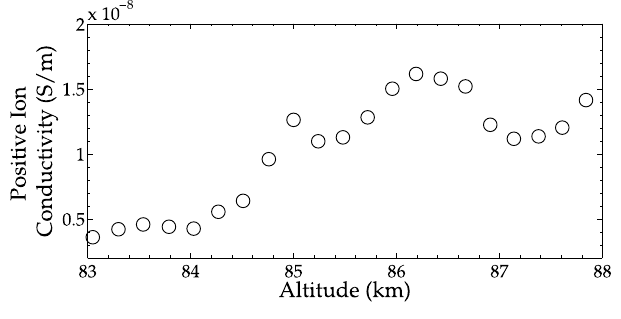
Fig. 6. High time resolution comparison of V 12 and V 15 at a shad- owing spike around 87 km. Probe V2 is in sunlight the entire time. V5 goes into the rocket shadow first – raising the V 15 potential dif- ference – followed by V1. The probes are nearly settled in voltage, which shows that the current balance is attained within the rocket shadow. Below about 84.5km, the conductivity is too low and the probes do not reach equilibrium, although the shadowing spike am- plitudes are larger.